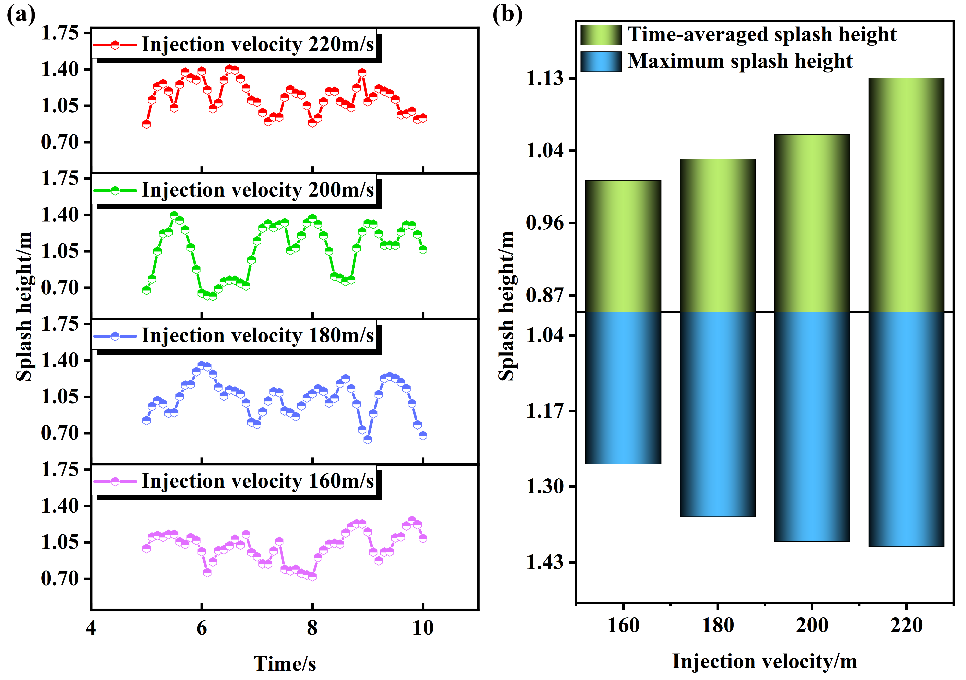
Figure 5. Splash height at different injection velocities ( a ) instantaneous distribution of splash height; ( b ) time ‐ averaged splash height and maximum splash height.